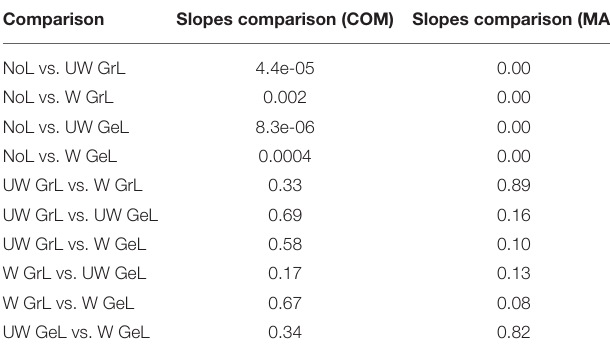
TABLE 4 | P -values for the pairwise comparison of the slopes for the source depth.